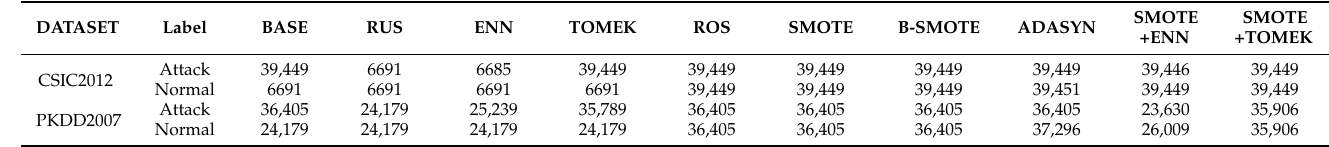
Table 5. Data distribution after sampling (datasets CSIC2012 and